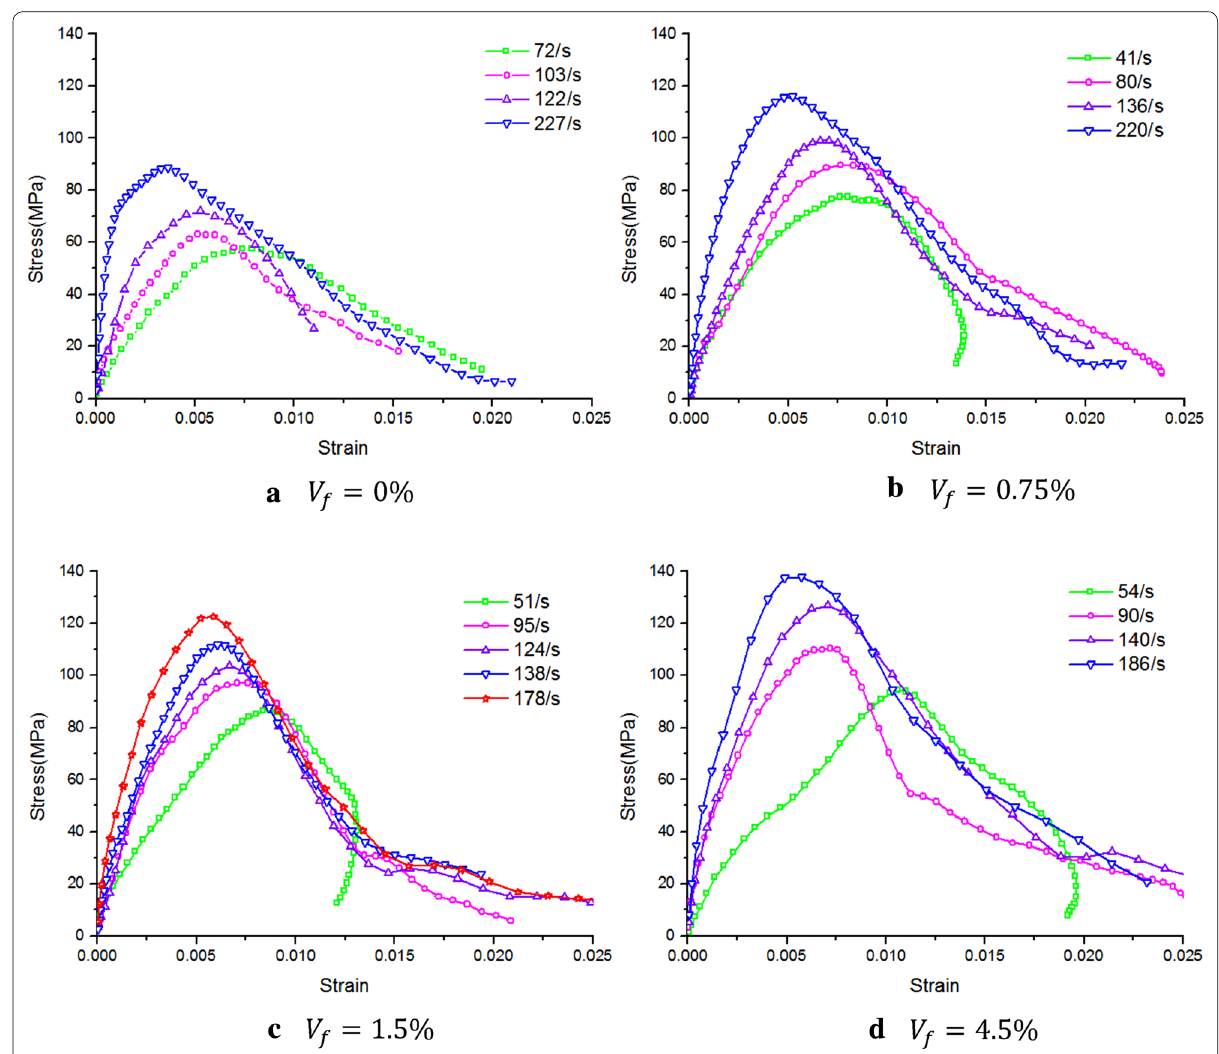
Fig. 7 Stress–strain curves of SFRC at 20